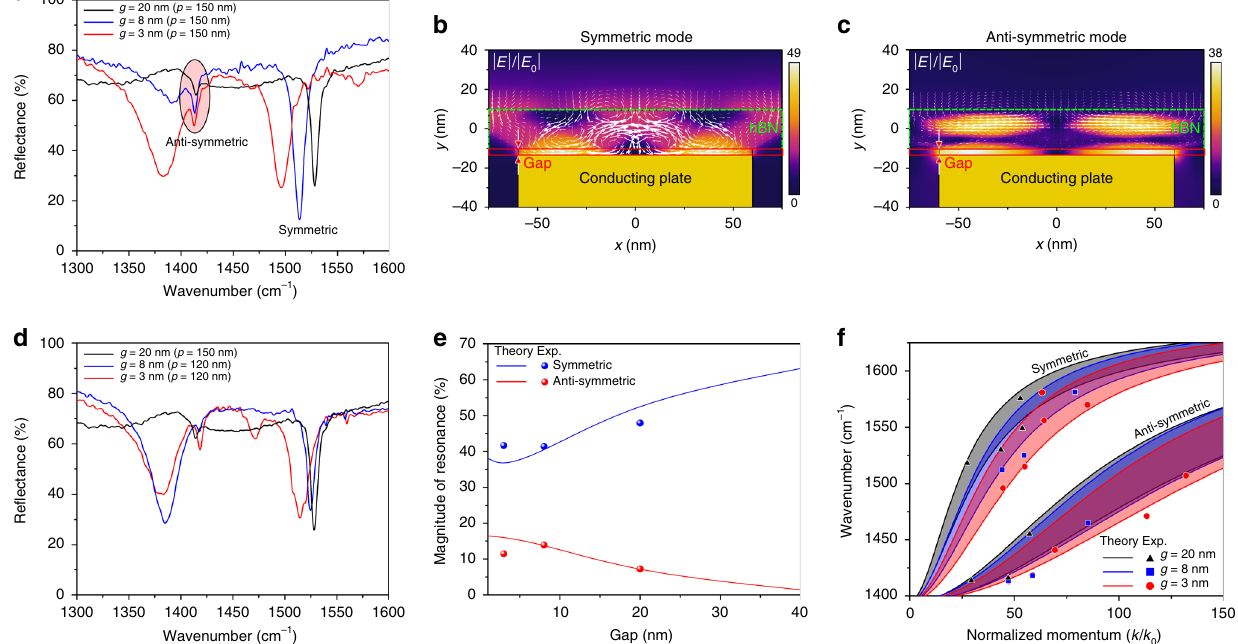
Fig. 3 Gap dependence and dispersion for h 10 BN. a The re fl ection spectra for g = 3, 8, and 20 nm given the periodicity of 150 nm. The spatial distribution of the electric fi elds for b the symmetric mode and c antisymmetric mode. The white arrows represent Poynting vectors. d Re fl ection spectra measured from the devices whose resonance wavelengths for the symmetric mode are almost aligned at the wavenumber of 1522 cm − 1 . e The gap dependence of the magnitude of a resonance as a function of the gap sizes for the symmetric and anti-symmetric mode at around the frequency of 1522 and 1416 cm − 1 , respectively. The solid lines denote the numerical results with constant scaling factors of 0.75 and 0.2 for the symmetric and antisymmetric case. f The in- plane momenta extracted from the measured spectra for different gap sizes of g = 3 (red circle), 8 (blue triangle), and 20 nm (black square) together with the analytical dispersions. For each gap size, the dispersion is calculated for t = 20 and 30 nm (the shaded area between two solid lines) to account for hBN thickness ( t ) variation in the fabricated